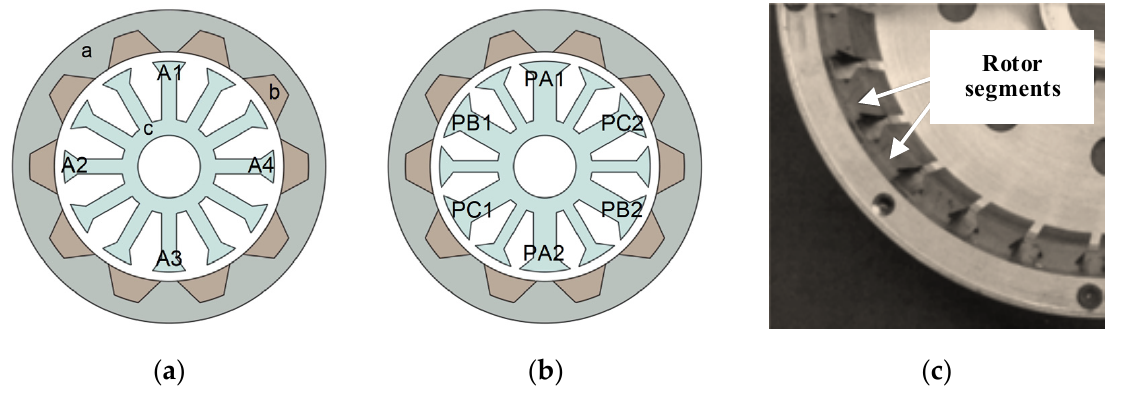
Figure 9. Schematic model of external segmented rotor SRM. ( a ) is FPW connection where “a” is the rotor sleeve and “b” the is outer segmental rotor, “c” is inter segmental rotor; ( b ) is the CW connection; ( c ) is the protype of the rotor.